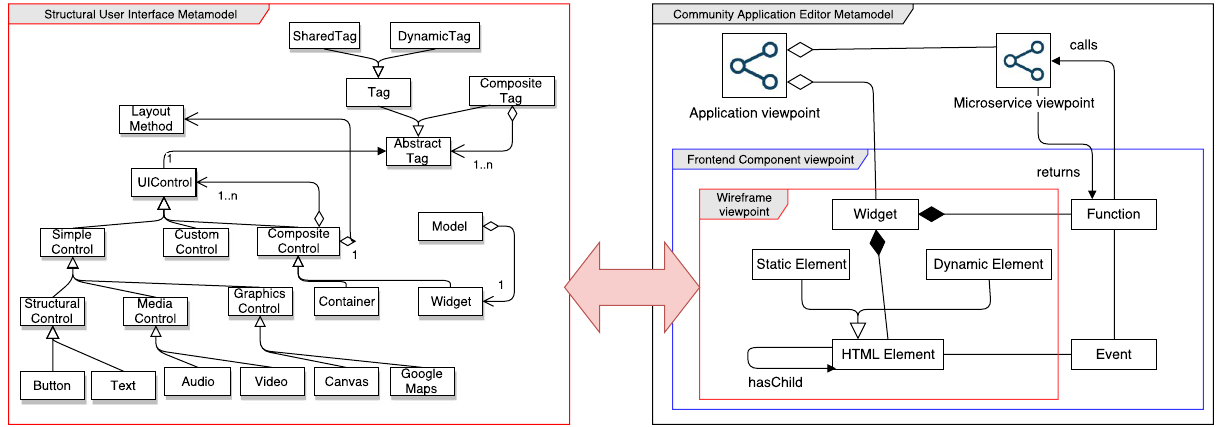
Fig. 6 Mapping of the SUIT- to the MDWE